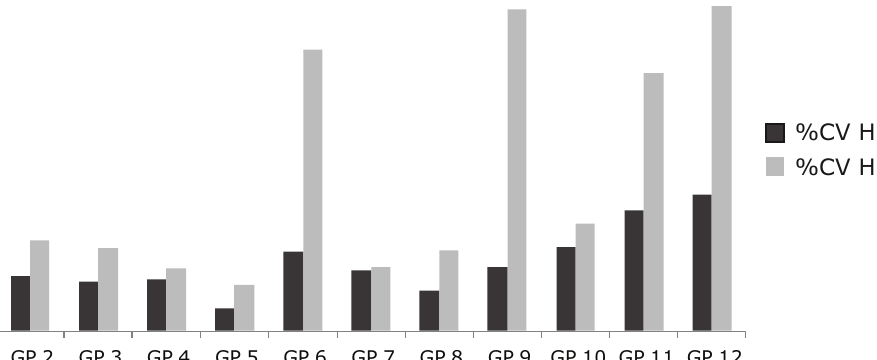
the immobilization of intact cells, the cells were resuspended in 70 m L of polyacrylamide gel (18.5% acrylamide:bisacrylamide 29.2:0.2, 375 mM Tris-HCl pH 7.5, 3 M urea, 0.1% APS, 1.5% TEMED) and left to polymerize on ice between 1 and 2 minutes.